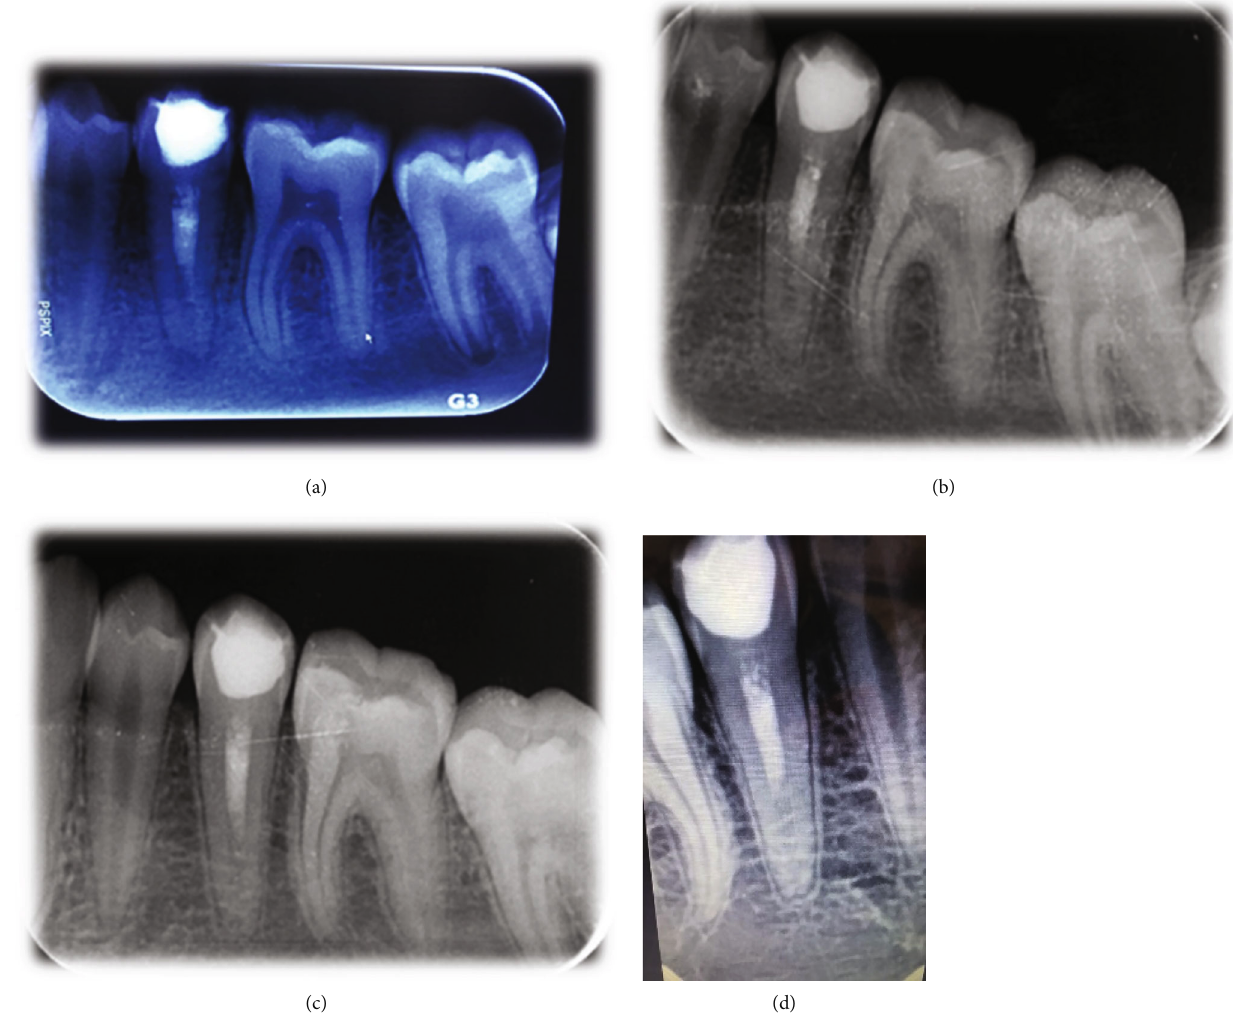
Figure 3: The periapical radiograph during follow-ups at months 3 (a), 6 (b), 12 (c), and 24 (d).